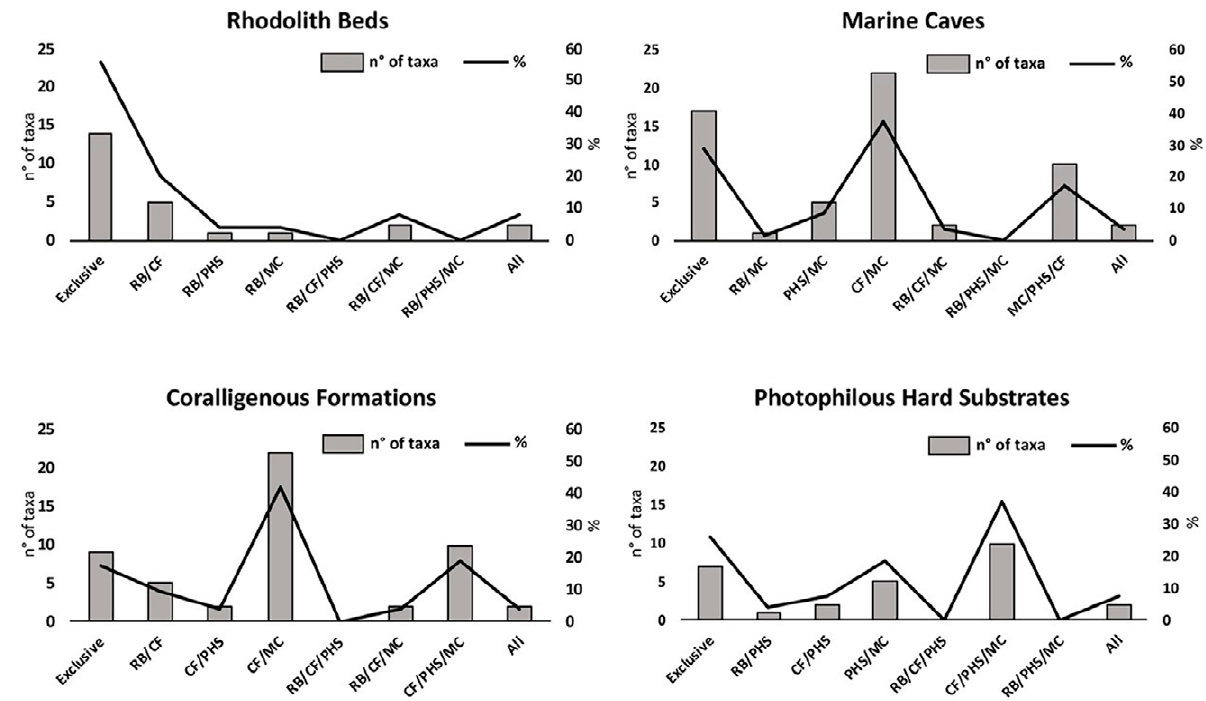
Fig. 3. – Sponge taxa distribution recorded in each habitat and shared across the four studied